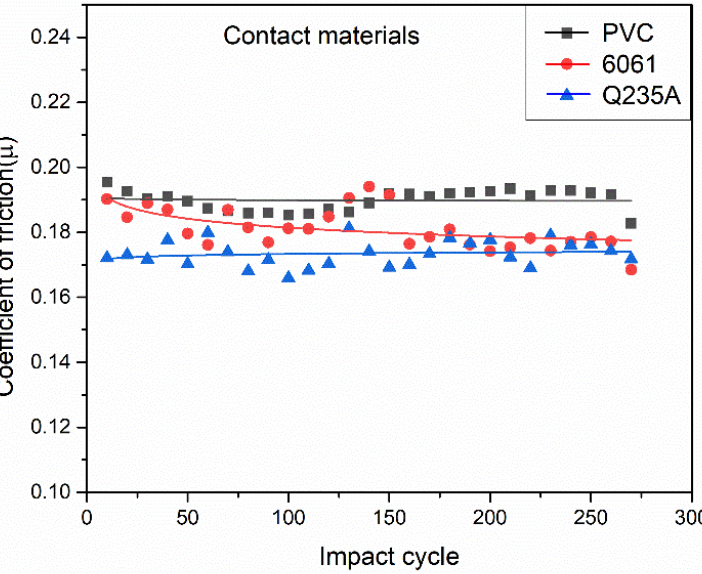
Figure 5. Changes in the coefficient of friction depending on different materials of pin specimens.